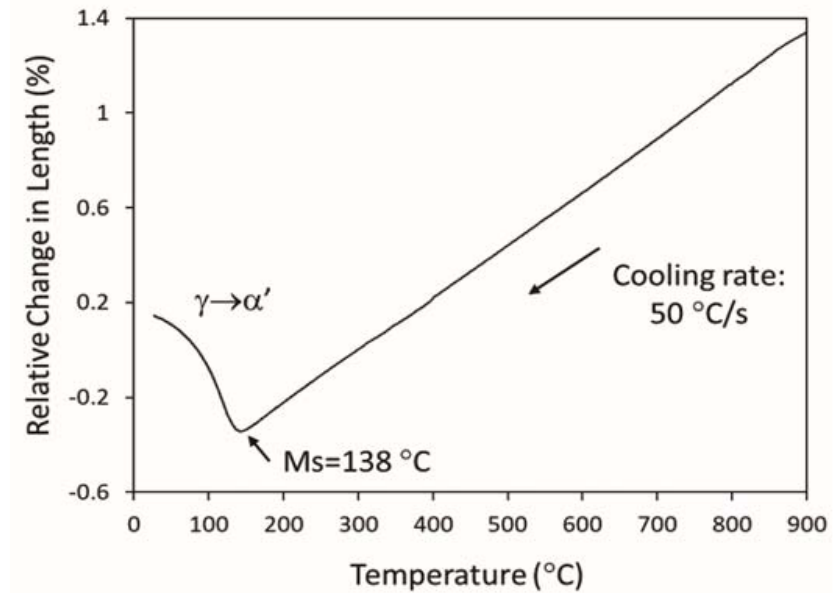
Figure 9. Characteristic dilatometry plot showing the temperature evolution of the relative change in length, during quenching at 50 ◦ C / s, for the steel under investigation. The approximate location of the Ms temperature (138 ◦ C) has been pinpointed by an arrow. In this plot symbols α and α ’ stand for austenite and martensite, respectively.